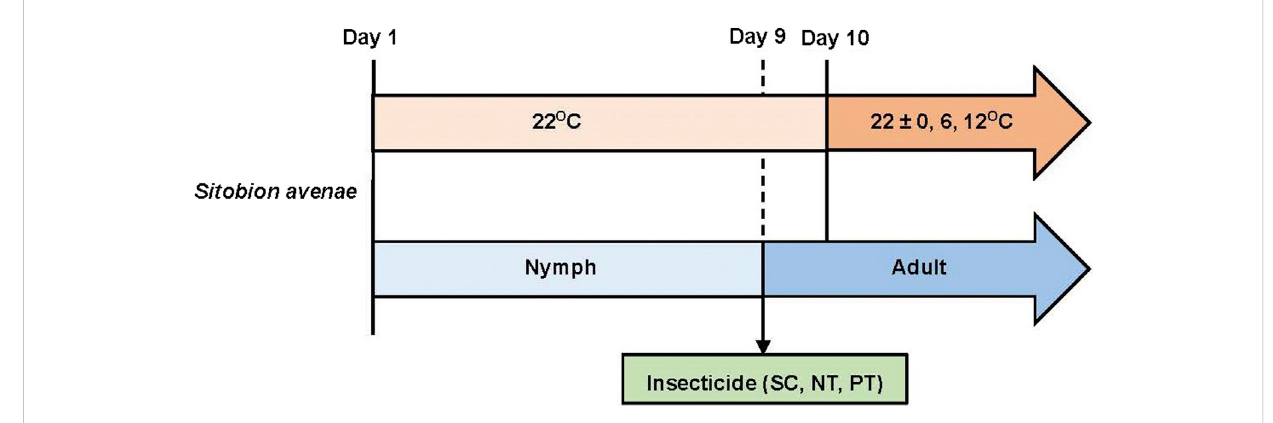
FIGURE 1 The experimental design including treatments and endpoints